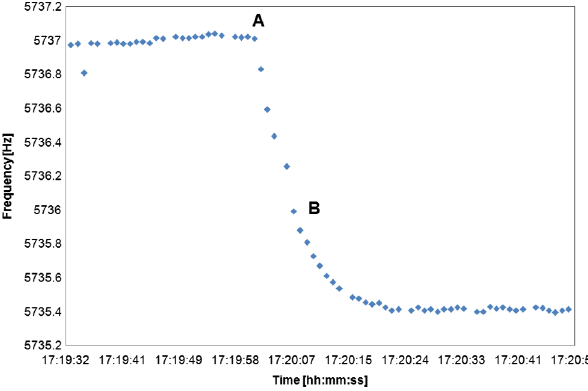
FIG. 7. Plot of frequency vs time for response time measure- ment. Point A: laser on; point B: temperature increase reaches 63.2% of saturation.